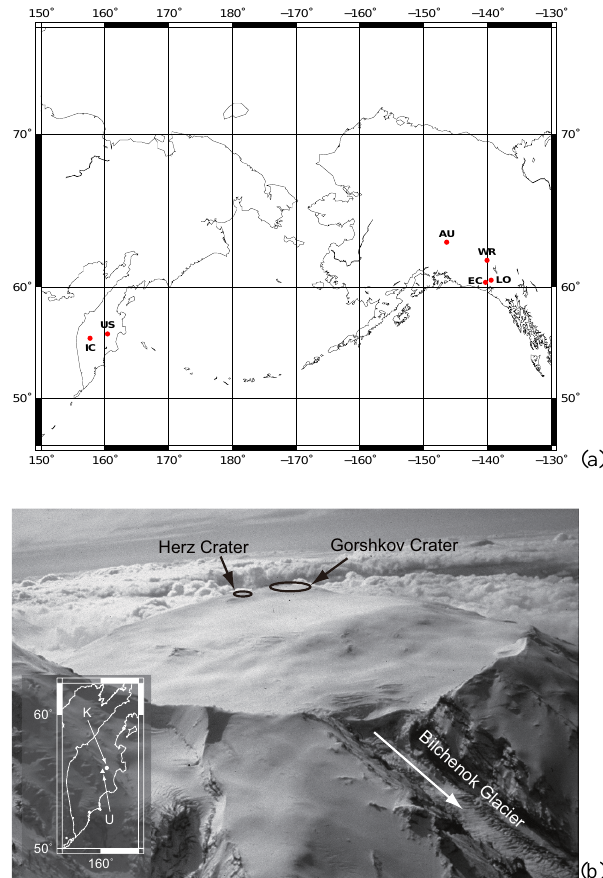
Fig. 1. (a) Deep ice core sites around the subpolar Pacific. US: Ushkovsky (Shiraiwa et al., 2001), IC: Ichinsky (Matoba et al., 2011), LO: Logan (Holdsworth et al., 1989; Shiraiwa et al., 2003; Fisher et al., 2004), EC: Logan Eclipse (Wake et al., 2002), WR: Wrangell (Yasunari et al., 2007), AU: Aurora Peak (Fukuda et al., 2011). (b) The north face of Ushkovsky volcano and the summit craters. Bilchenok Glacier is the main outlet from the summit ice cap. Inset the location of Ushkovsky volcano (U) and the nearby weather station, Kljuchi